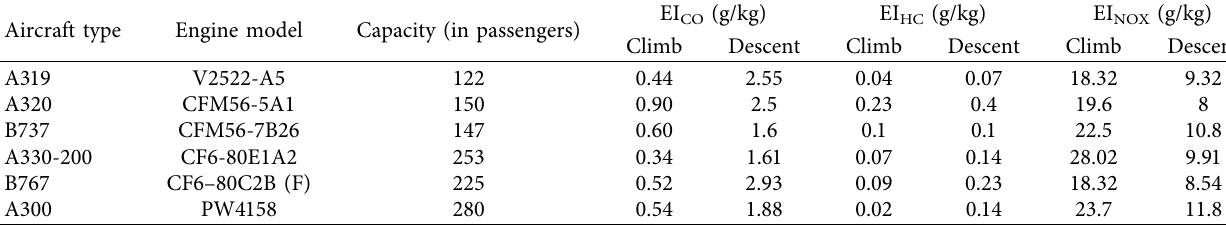
Table 3: Relevant data of each type of aircraft.